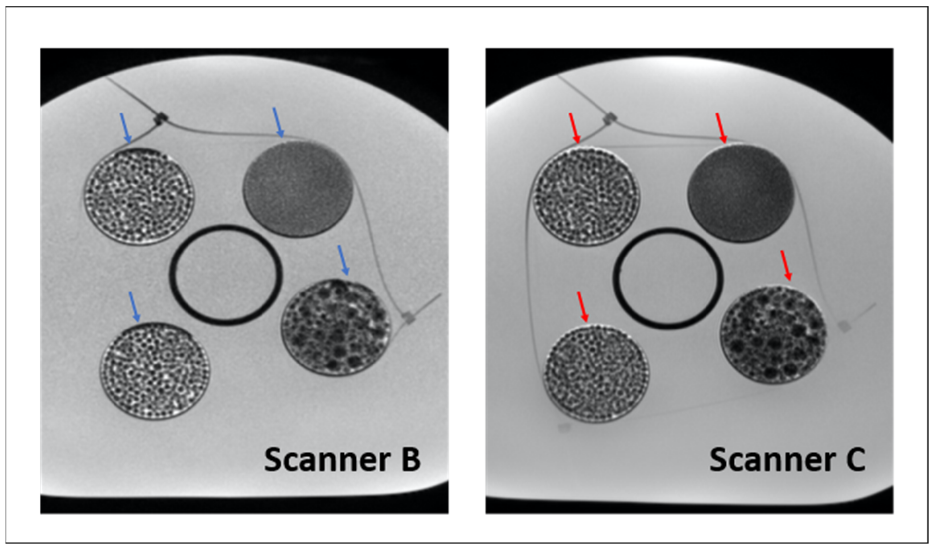
Figure 6. Comparison between water-fat shift artifacts between scanner B ( left ) and scanner C ( right ). Arrows in blue indicate the overlap region of the artifact for different inserts in scanner B. Arrows in red indicate the overlap region of the artifact for different inserts in scanner C. Window width/window level for the image of scanner B: 1970/1165; window width/window level for the image of scanner C: 2208/1104.